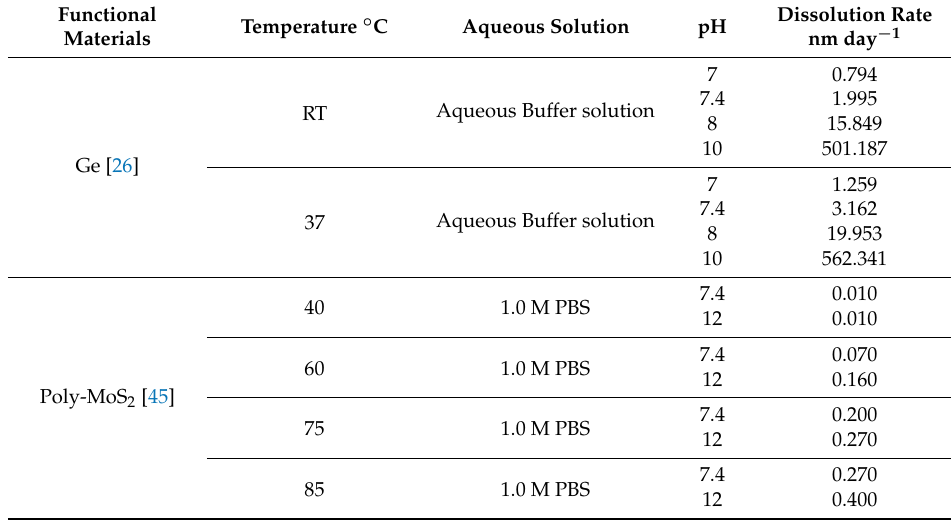
Table 3. The dissolution behavior of Ge and 2D MoS 2 under different conditions [26,45].